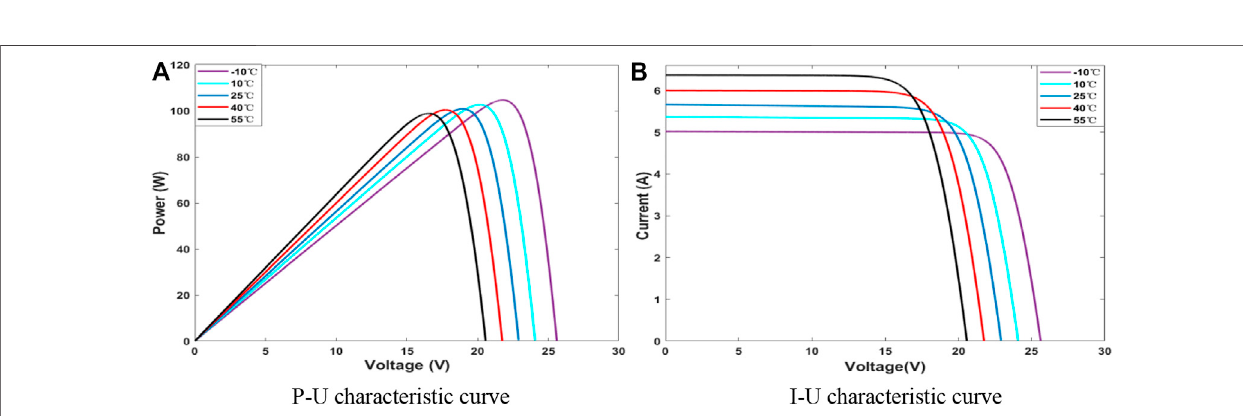
FIGURE 3 | I – U characteristic curve under the same illumination intensity and different temperatures under uniform